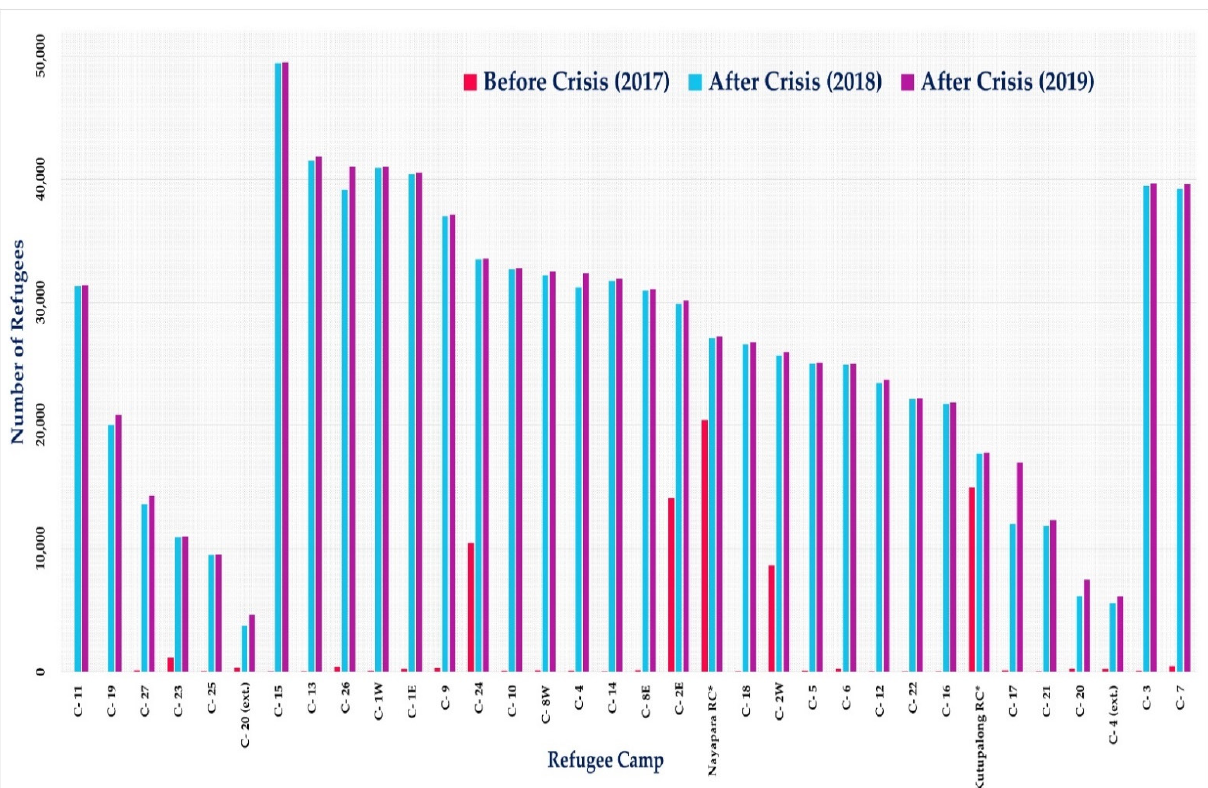
Figure 1. Camp-wise Rohingya refugee changes, pre and post refugee crisis (between 2017 and 2019), among thirty-four refugee camps in Ukhiya-Teknaf. Here, C = camp; RC* = registered camp; Ext. = extension. (Data source: [10]).